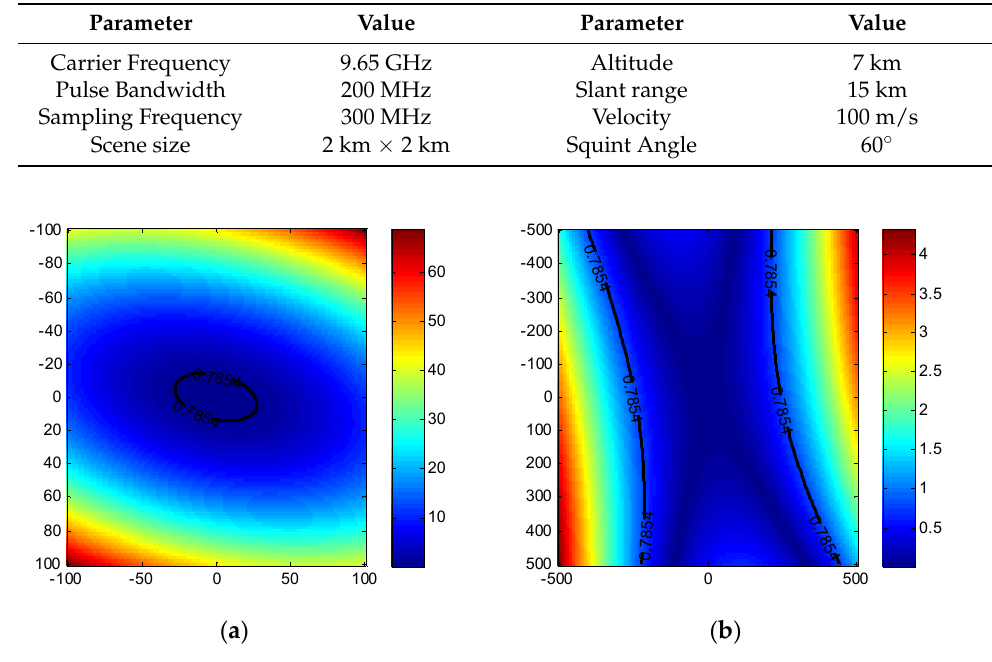
Figure 2. Phase errors caused by wavefront curvature error. ( a ) CPFA; ( b ) EPFA. The range error